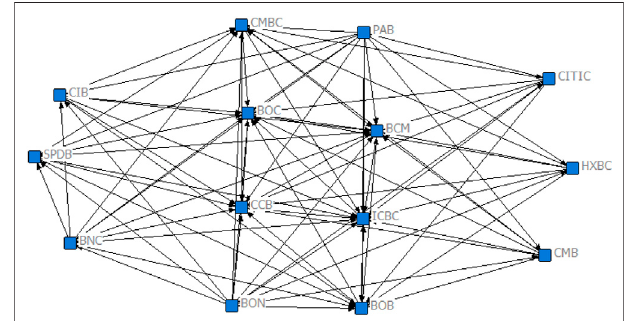
FIGURE 2 | Jump risk correlation network of commercial